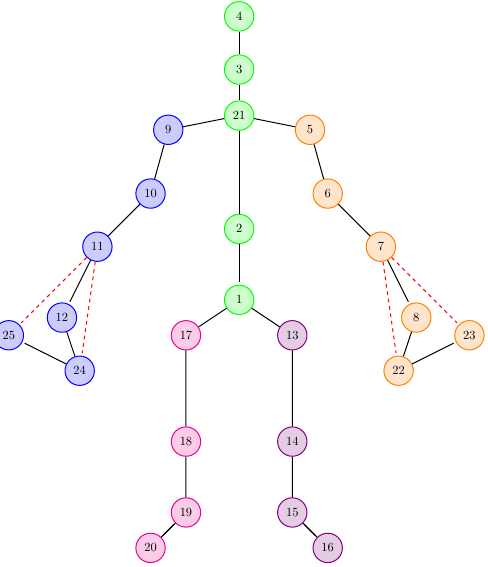
Figure 2. The human skeleton in the format generated by the Kinect